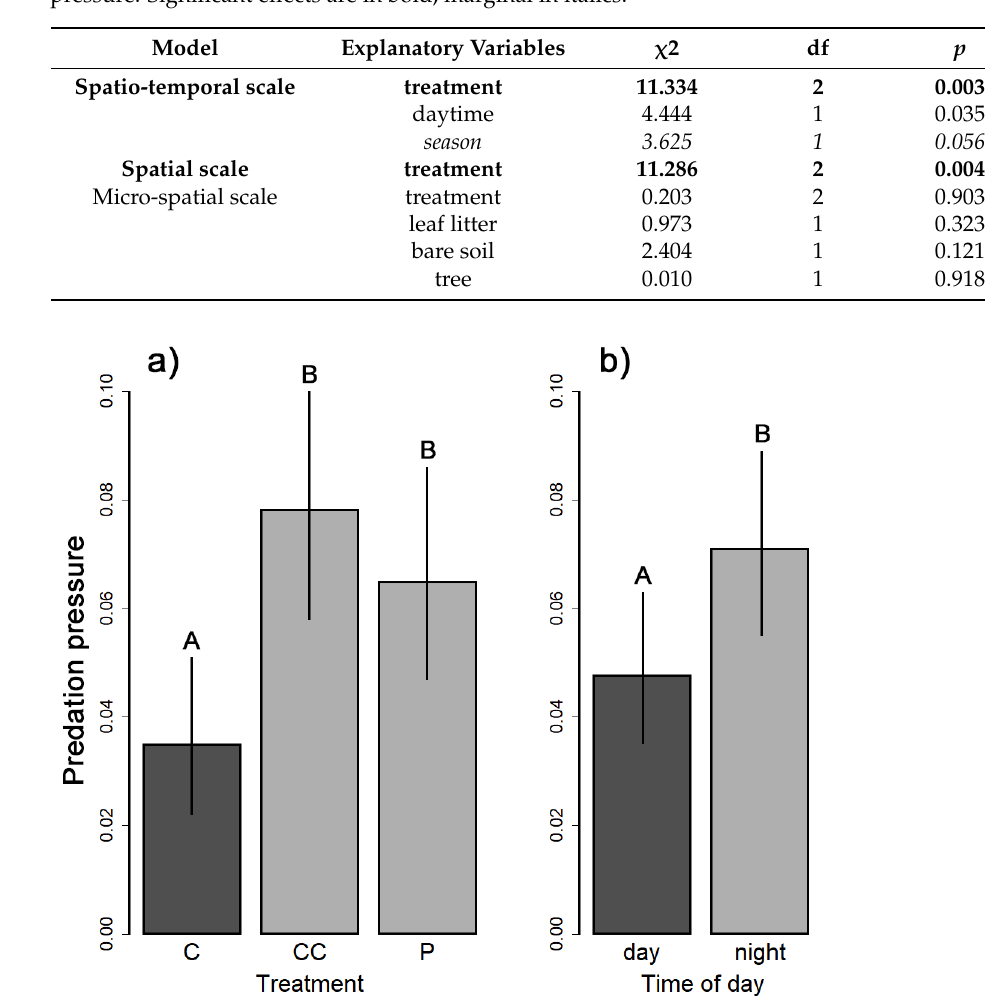
Table 3. The effects of treatment, daytime, season and environmental variables on the predation pressure. Significant effects are in bold, marginal in italics.